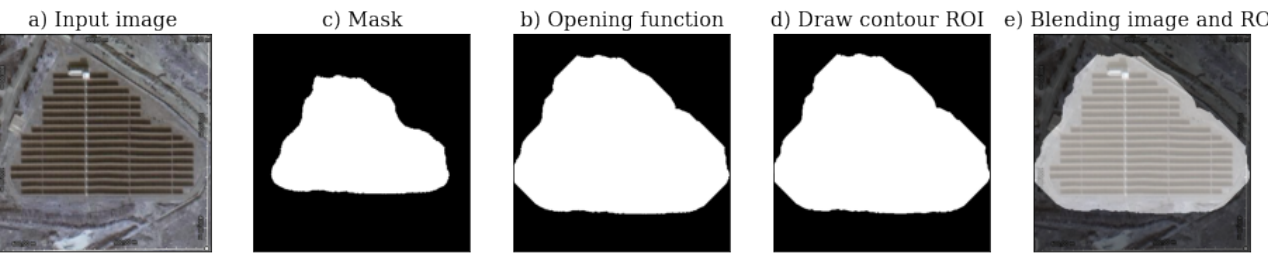
Figure 7. Steps of boundary extraction by DL server, and OpenCV functions in Arak PV plant.